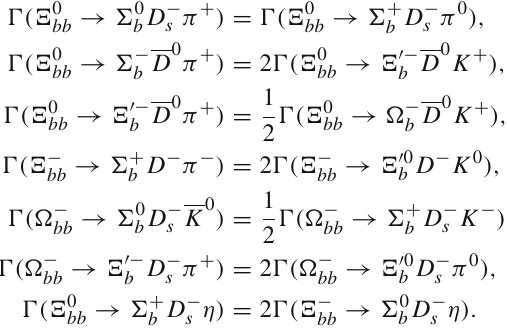
→ (cid:2) (cid:4) 0 π 0 ), D − s b bb → (cid:6) 0 η). D − s b bb → (cid:2) 0 K 0 η), bb b